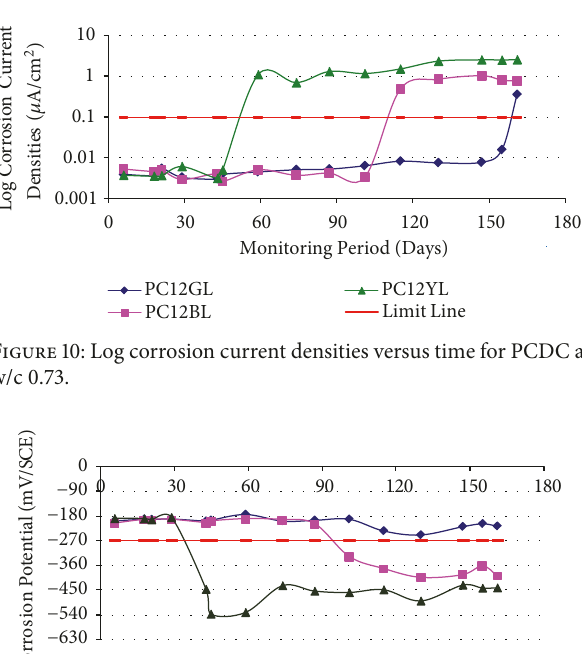
Figure 9: Corrosion potential versus time for PCDC at w/c 0.73.